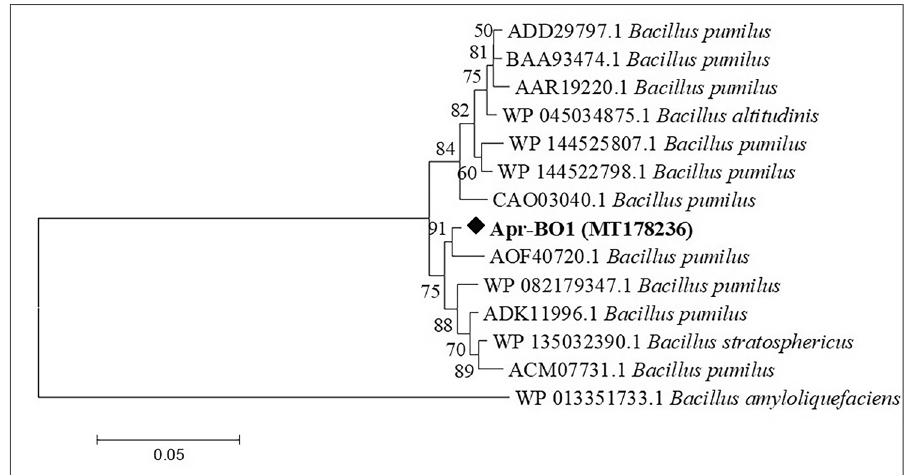
Figure 3. Phylogenetic analysis of cold-active Apr-BO1 with other highly identical alkaline proteases, using amino acid sequences. MEGA 7.0 software was used to deduce the evolutionary history. Next to branches are the bootstrap tests with 1000